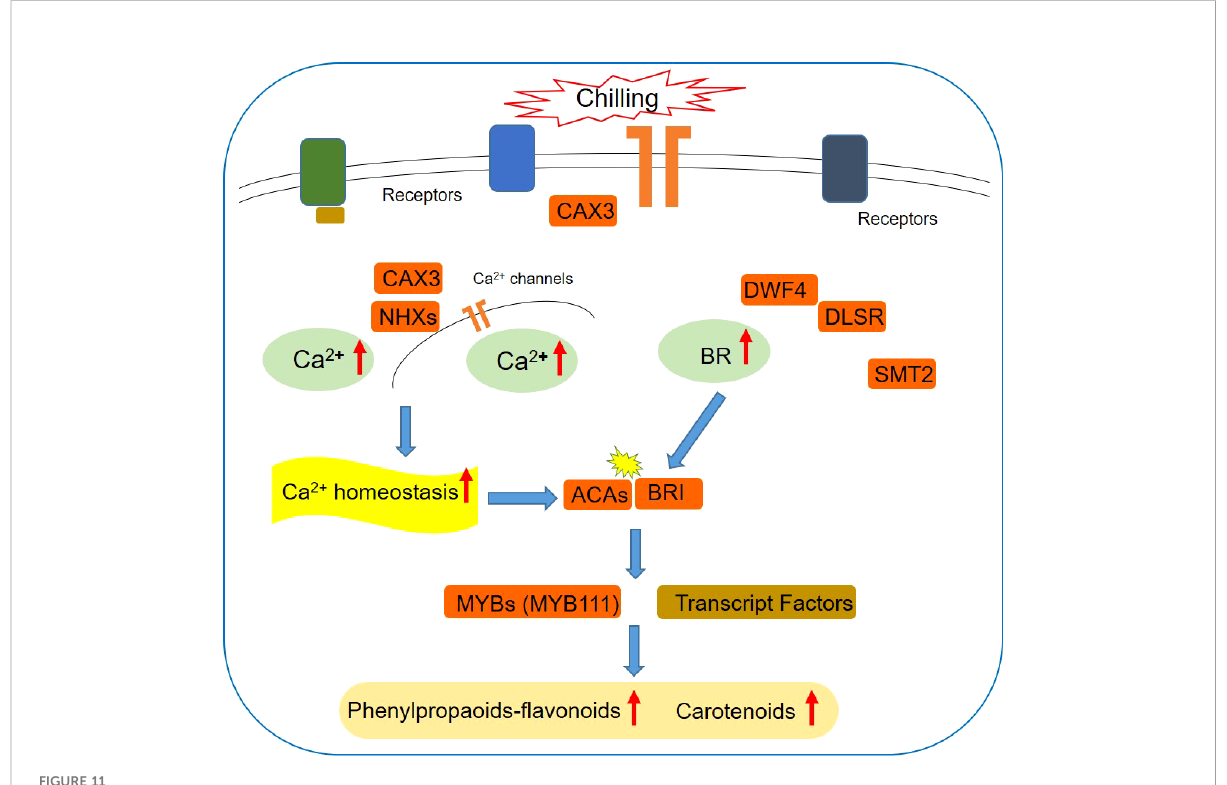
FIGURE 11 The overview of major fi ndings in this